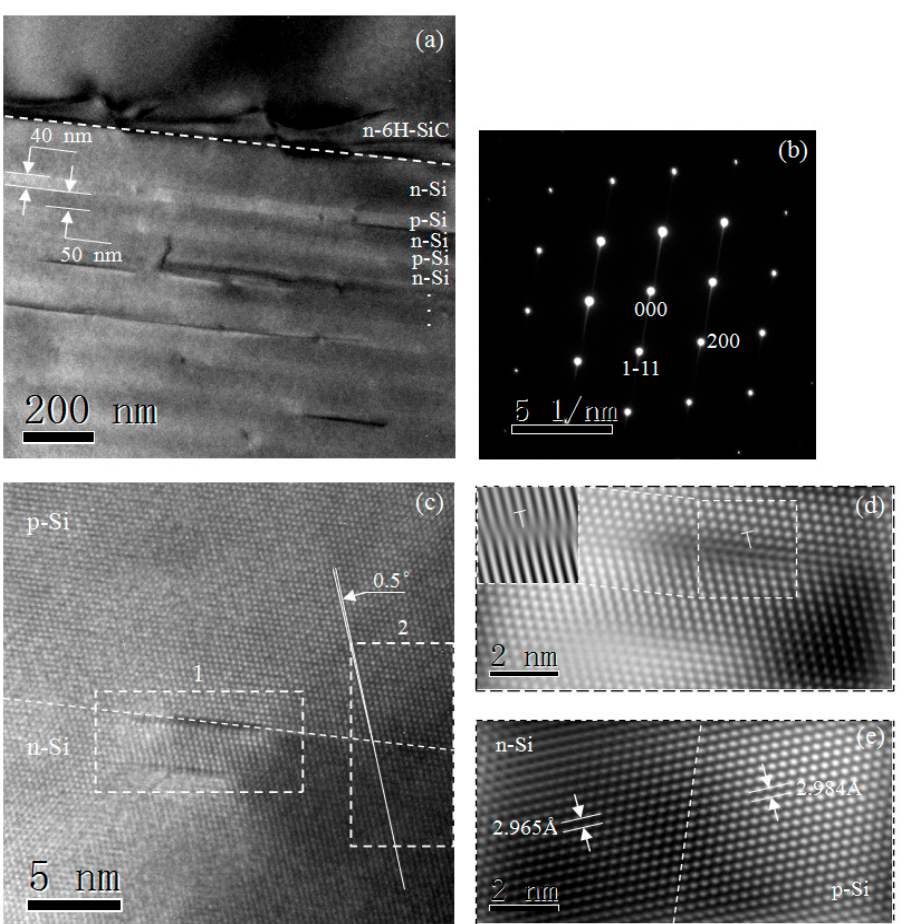
Figure 4. TEM and selected area electron diffraction (SAED) images of the Si-DSL structures with seven p/n-Si junctions on 6H-SiC. ( a ) Cross-sectional low magnification TEM image; ( b ) SAED patterns of the Si films; ( c ) HRTEM image of the p-Si/n-Si interface; and the processed HRTEM images of region 1 ( d ) and region 2 ( e ) by using the Fourier filtering technique.